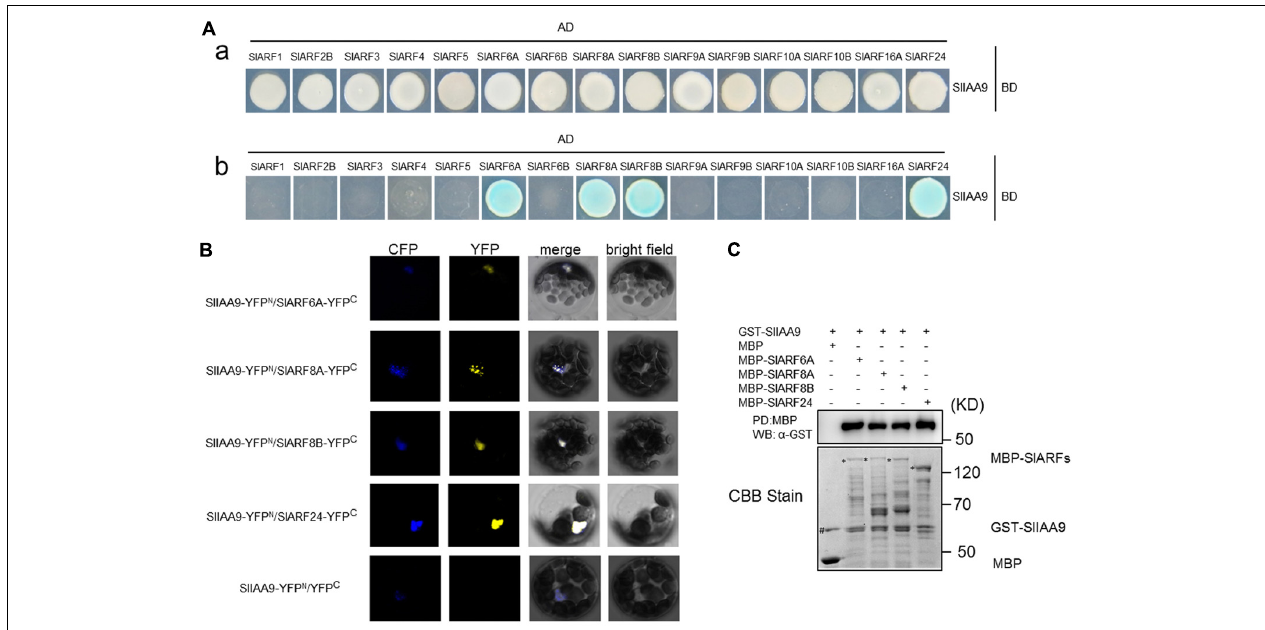
FIGURE 1 | Interaction of SlIAA9 and the cloned SlARF proteins in vivo and in vitro . (A) The yeast cells grown on SD/-Leu/-Trp (a) and SD/-Ade/-His/-Leu/-Trp + 40 ug ml − 1 X-gal (b) . (B) SlIAA9 interacts with SlARF6A, SlARF8A, SlARF8B, and SlARF24 in Arabidopsis thaliana cell culture protoplasts. YFP fluorescence was detected when SlIAA9-YFP N was coexpressed with SlARF6A-YFP C , SlARF8A-YFP C , SlARF8B-YFP C , and SlARF24-YFP C , respectively. (C) GST-fused SlIAA9 proteins were incubated with MBP, MBP-SlARF6A, MBP-SlARF8A, MBP-SlARF8B or MBP-SlARF24 beads (PD:MBP). The incubated beads were washed and pelleted for immunoblot analysis with α -GST antibody. The protein inputs are indicated by Coomassie Brilliant Blue (CBB) staining.